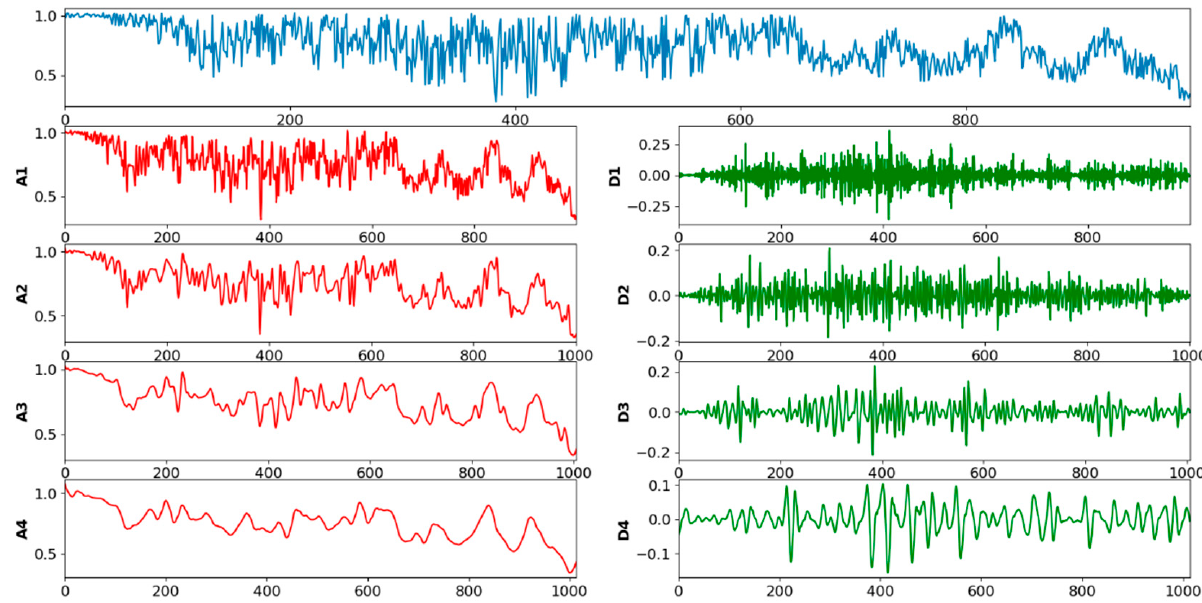
Figure 7. Signal reconstruction for a sample dataset with the wavelet method.